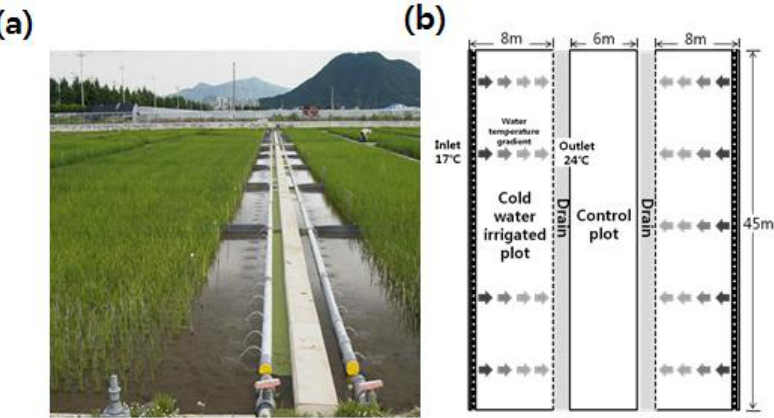
Figure 1. Views of the paddy field of Chuncheon substation used for cold tolerance screening ( a ) and diagram of the paddy field containing a cold-water-irrigated plotw and a control plot ( b ). In the cold-water-irrigated plot, 17 °C cold water was supplied through pipelines to a field at a 5 cm water depth during the entire rice growth period, from 20 days after transplanting to grain maturity. Depending on the water flow, a water temperature gradient was formed in the 8 m-long cold-water-irrigated plot, from 17 °C at the inlet to approximately 24 °C at the outlet. The normal plot with natural water temperature was used as a control.